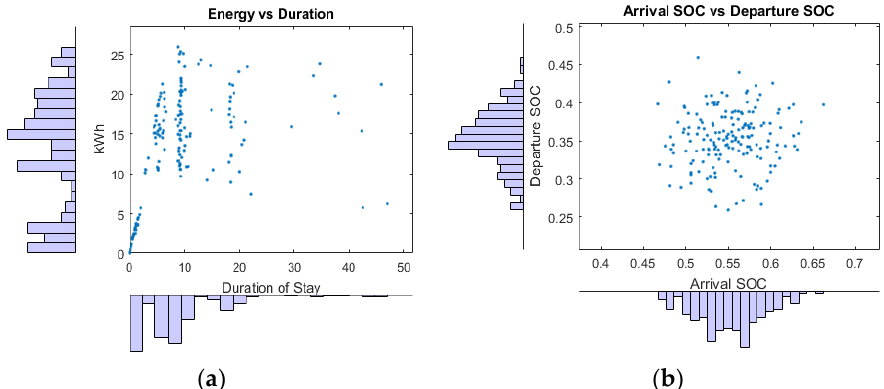
Figure 3. ( a ) Duration of stay and energy dispatched distribution and correlation ( b ) EV arrival and departure SoC distribution and correlation.